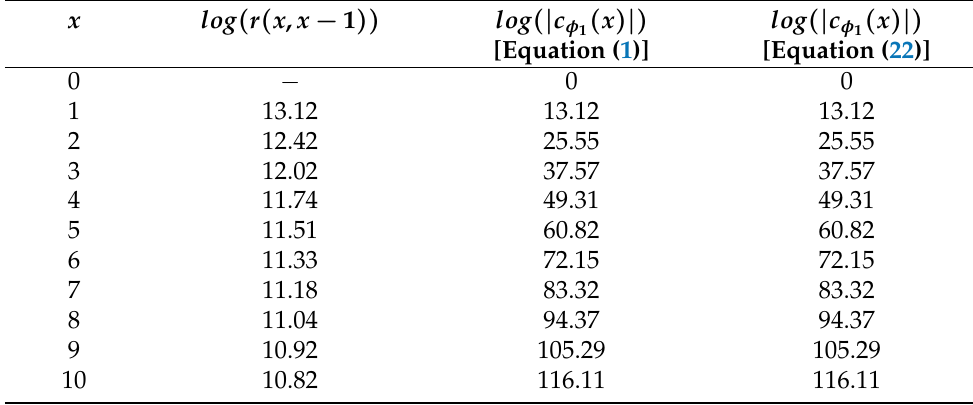
Table 1. Comparison of methods to calculate number of